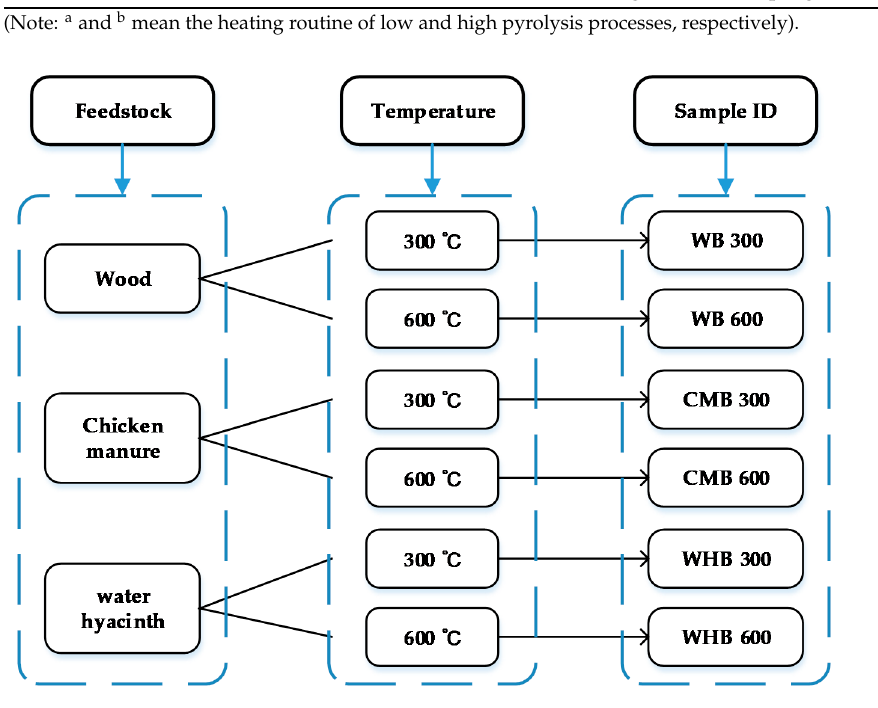
Figure 1. Biochar production conditions and sample grouping.